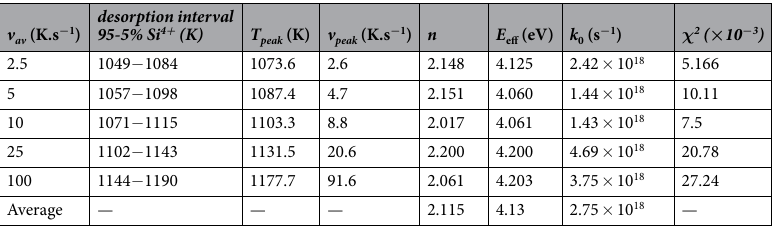
desorption interval v av (K.s − 1 ) 95-5% Si 4 + (K) T peak (K) v peak (K.s − 1 ) n E eff (eV) k 0 (s − 1 ) χ 2 ( × 10 − 3 )